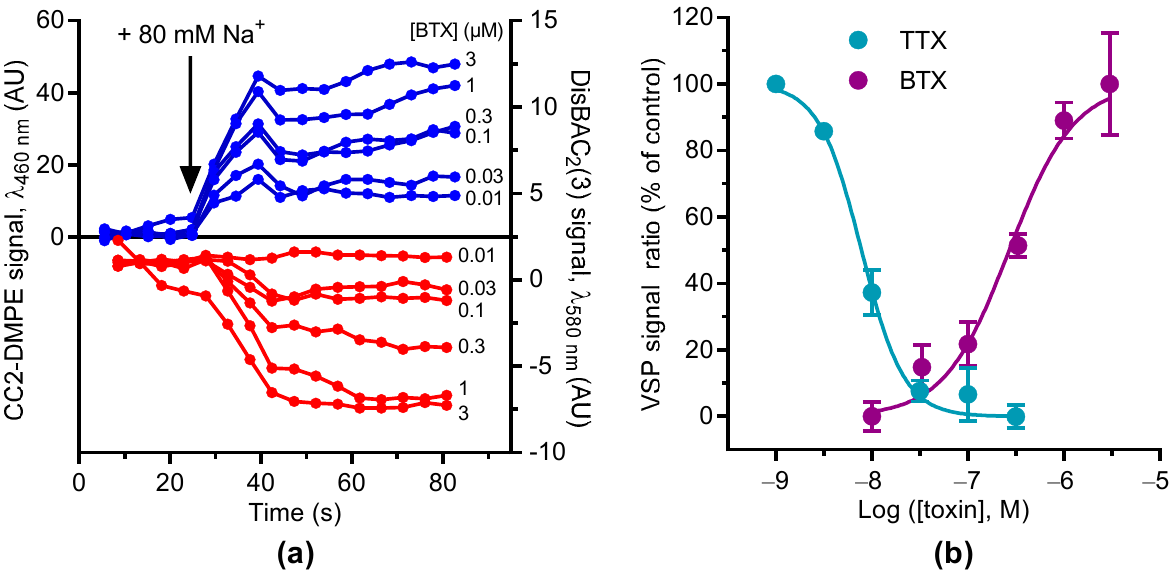
Figure 3. Monitoring the BTX activation of Na V channels using VSP in GH3b6 cells. ( a ) Representative kinetic traces illustrating the fluorescence emission of CC2-DMPE ( λ = 460 nm, blue line) and DisBAC2(3) ( λ = 580 nm, red line) in the presence of increasing concentrations of BTX (from 0.01 to 3 µM) before and after raising the Na + concentration to 80 mM. Data are the mean of three wells. ( b ) Concentration–response curves of a BTX-induced VSP signal. BTX induced an increase in VSP signal ratio in a concentration-dependent manner. TTX decreased the VSP signal ratio induced by BTX at 1 µM in a concentration-dependent manner. Normalized data were calculated with four end points of the fluorescence emission ratio (Signal ratio CC2-DMPE/DisBAC2(3)) kinetics. Data were best fitted with the Hill–Langmuir equation with a variable slope. For BTX, EC 50 = 0.27 ± 0.06 µM, Hill slope = 1.21 ± 0.26. For TTX, IC 50 = 8.58 ± 1.67 nM, Hill slope = 1.53 ± 41. Data are mean ± SEM ( n = 3).